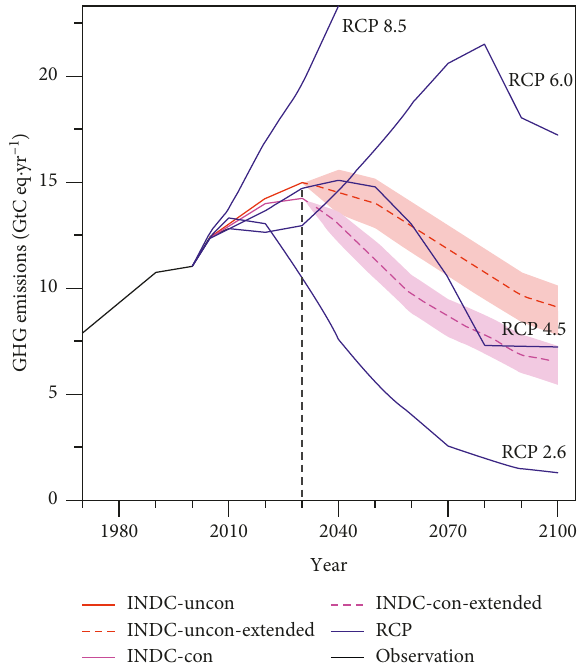
Figure 2: Global INDC emissions compared with representative concentration pathway (RCP) scenarios. The black line shows the historical observed emissions. The blue lines show future RCP emission scenarios. Colored lines show Intended Nationally De- termined Contribution (INDC) emissions under the unconditional pledge (red line) and conditioned pledge (pink line). Solid (red and pink) lines represent emissions before 2030 and dashed lines represent emissions after